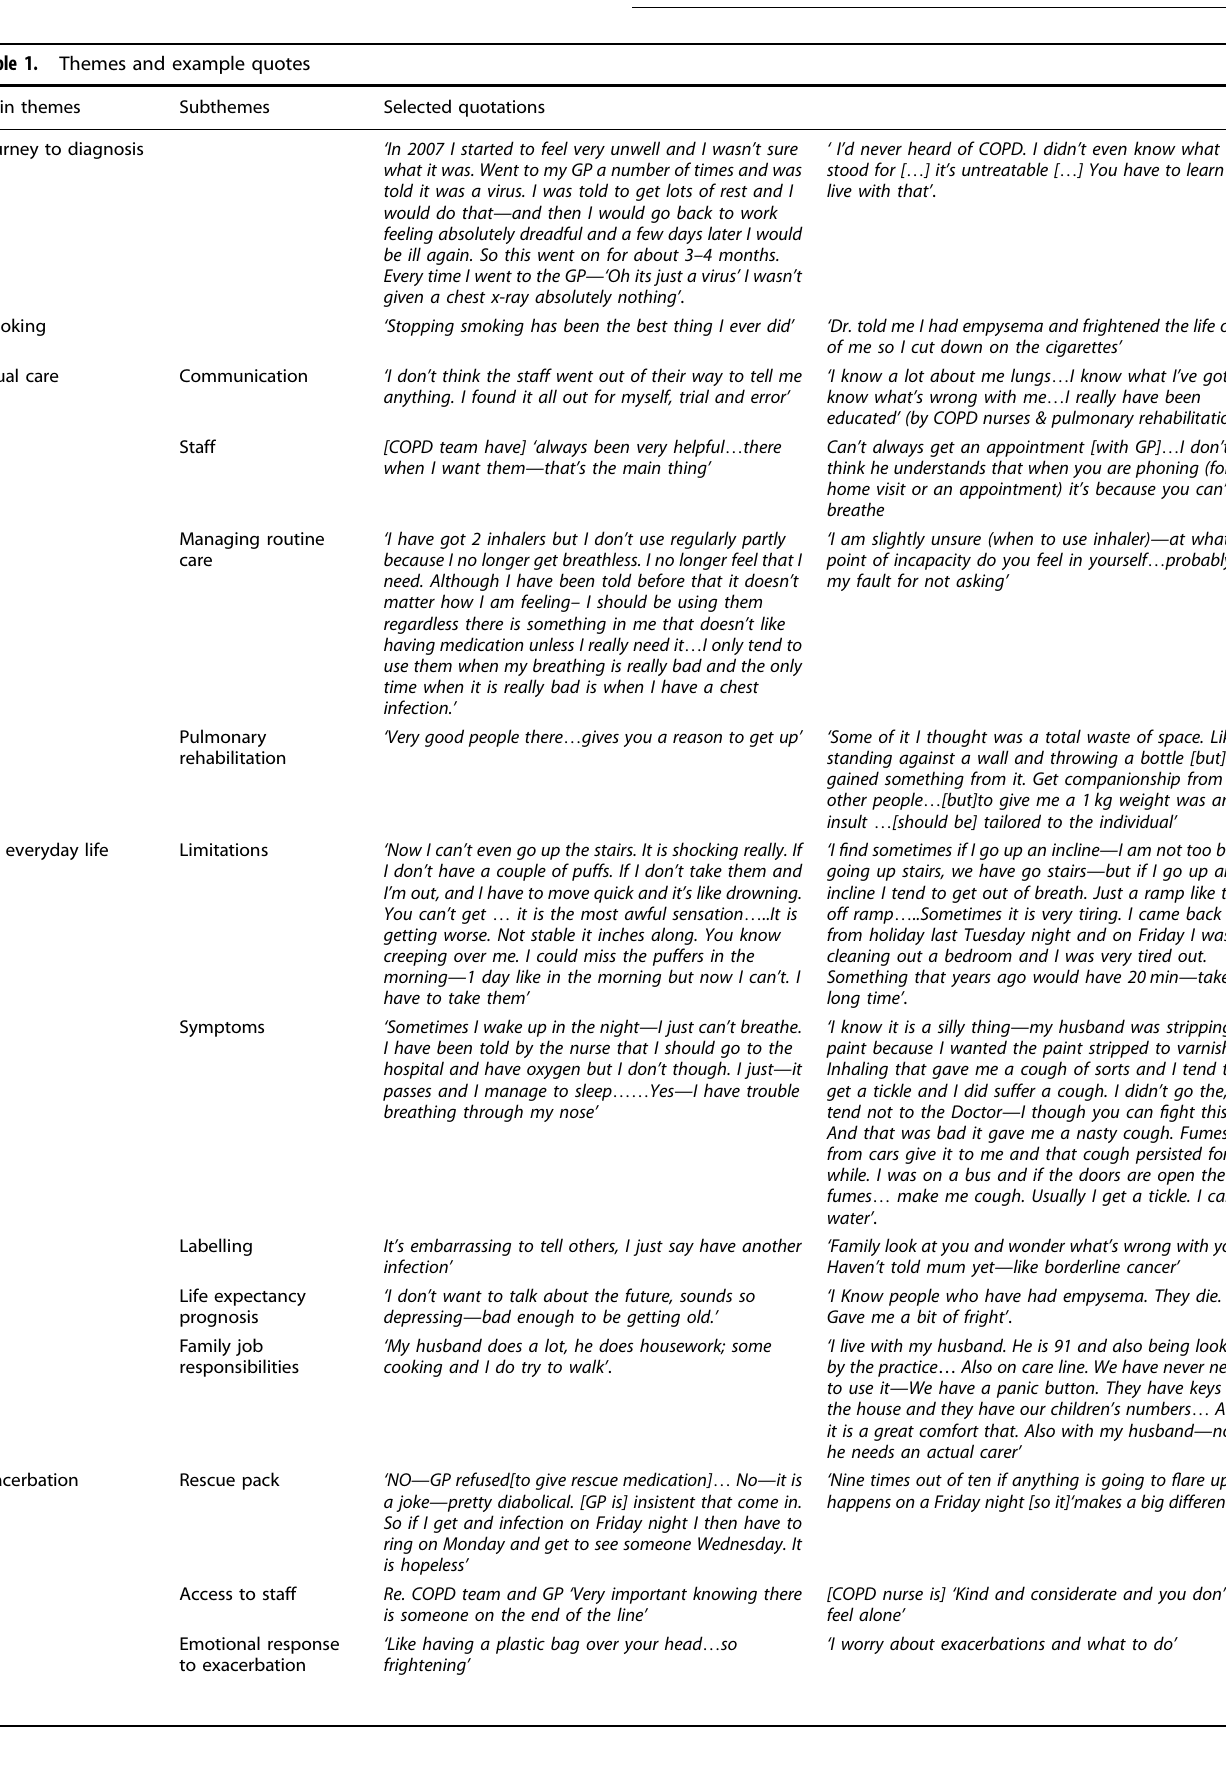
Table 1. Themes and example